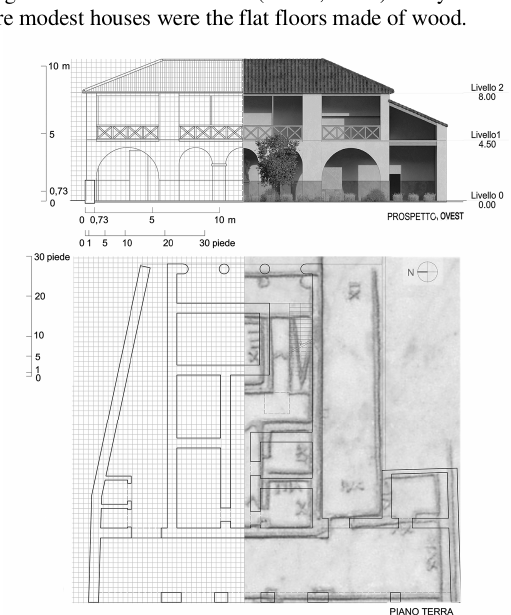
Figure 5a. Aedificium monumentalis (a). Use of the grid to compare the proportions of the southern elevation of the temple with the proportions obtained by studying the iconographic documents